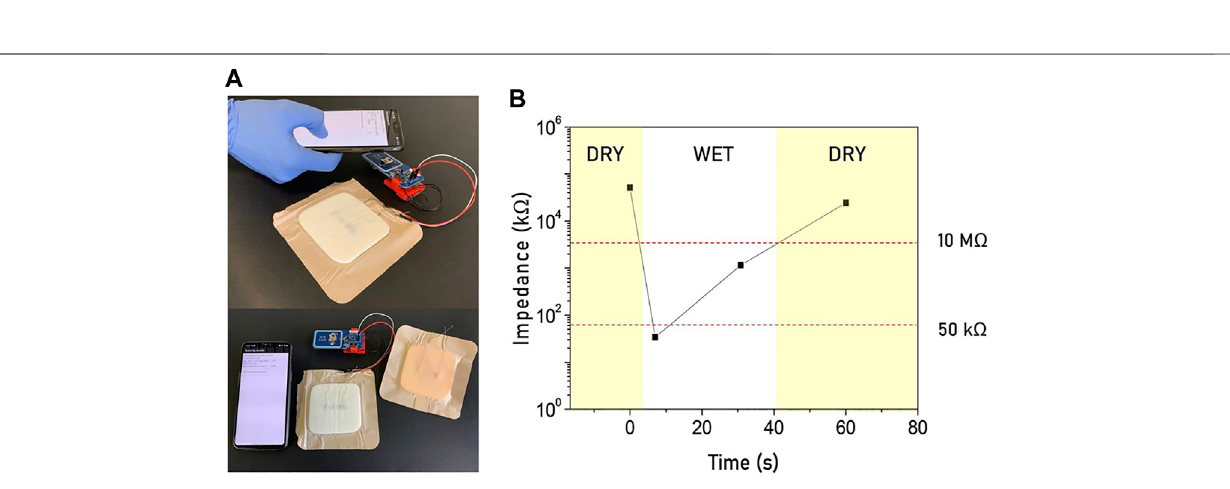
Frontiers in Physics |